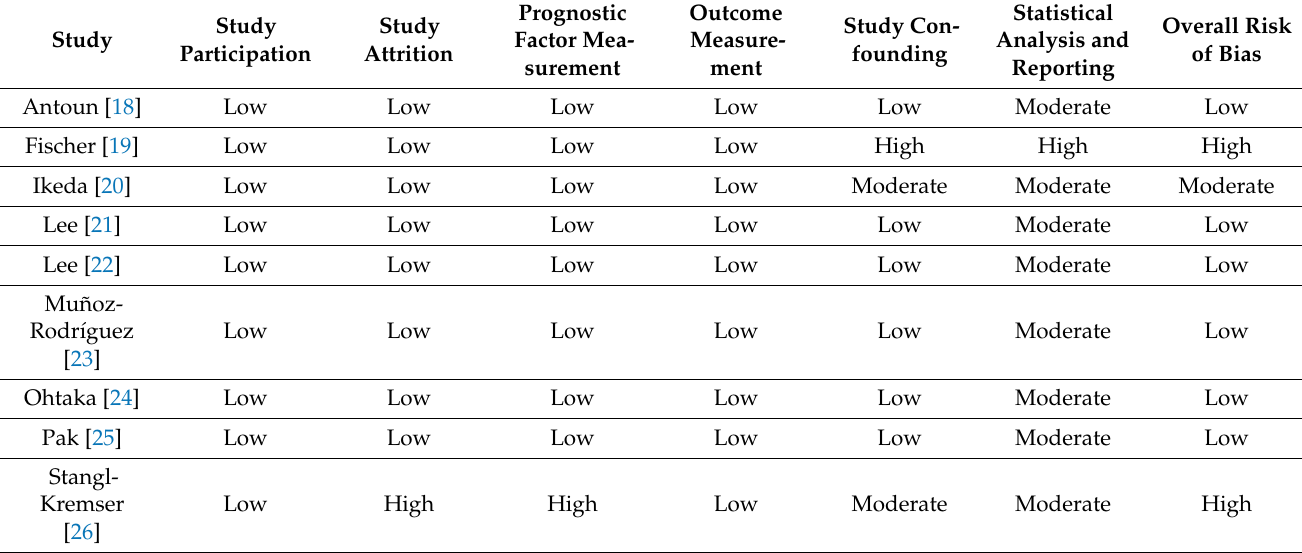
Table 2. Risk of bias